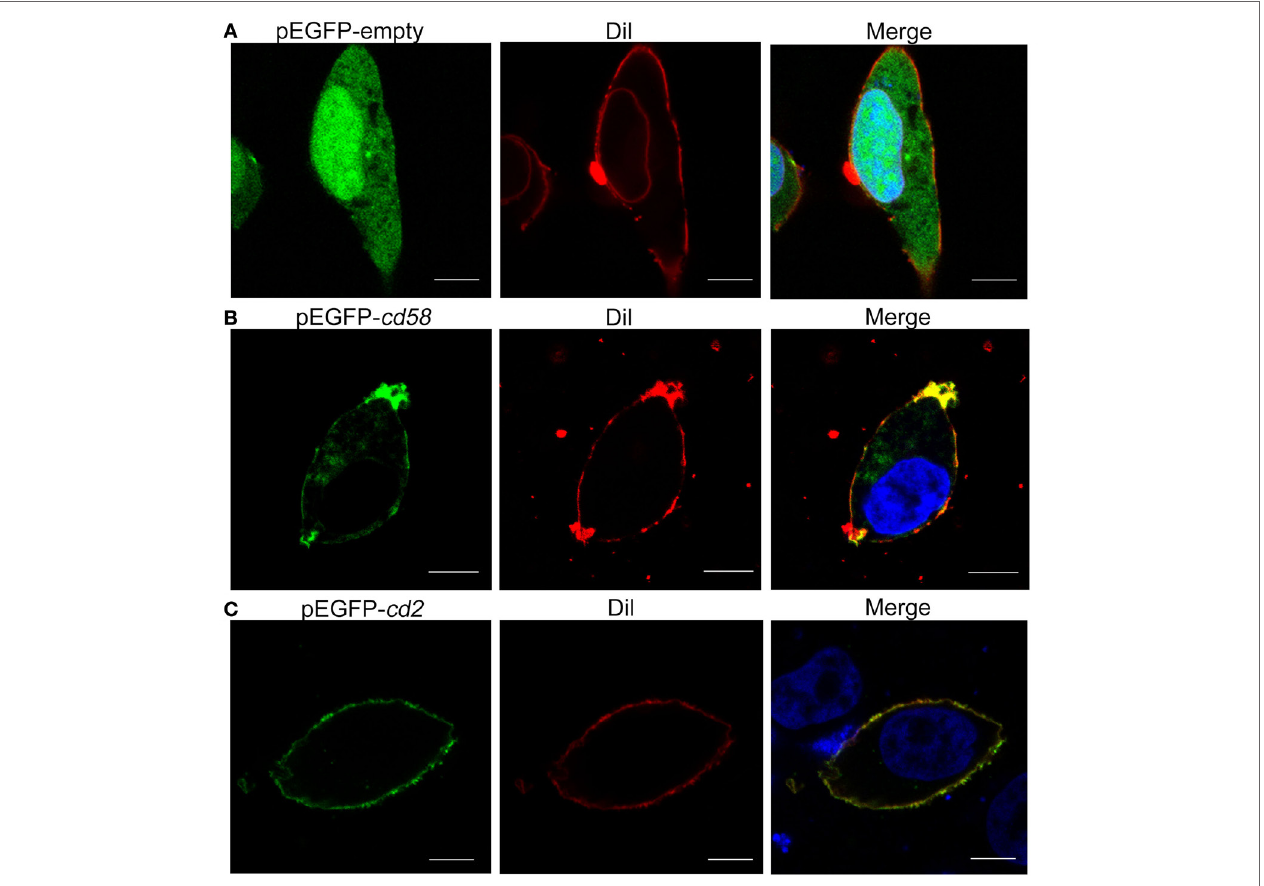
FigUre 4 | Subcellular localization analyses of Cd58 (B) and Cd2 (c) in HEK293T cells. Cells were transfected with empty control (a) or pEGFP- cd58 and pEGFP- cd2 (B,c) plasmids. Cd58 and Cd2 were clearly located on the cell surface membranes. Images were captured under a two-photon laser scanning confocal microscope (Zeiss LSM-710; original magnification, 630 × ). Scale bars, 10